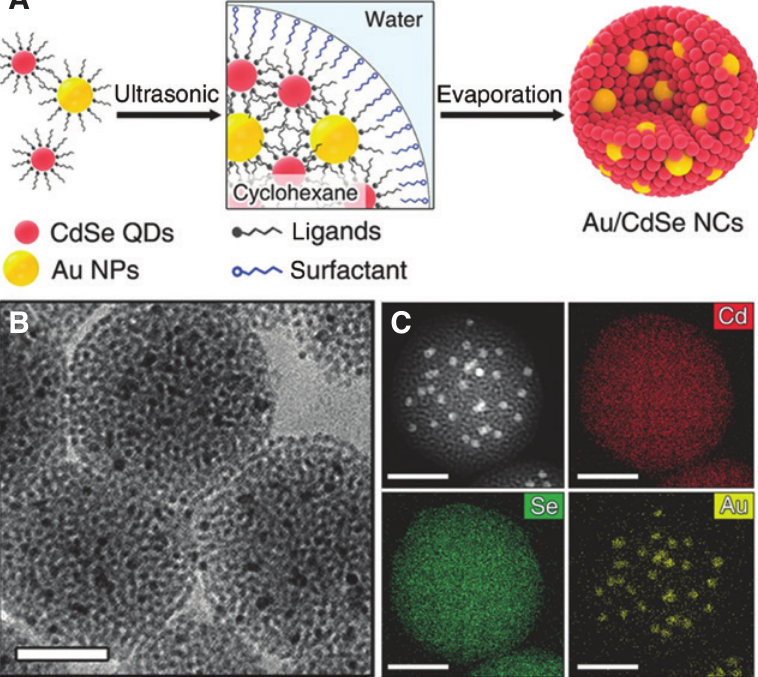
Figure 6: Preparation of nanoassemblies of AuNPs and CdSe QDs through the formation of emulsions. (A) Illustration of the process. Hydrophobic nanoparticles in cyclohexane are mixed with water and sonicated to form emulsions. (B) TEM image of emulsions containing AuNPs and CdSe QDs. (C) High-angle annular dark-field STEM image and corresponding EDS images for Cd, Se, and Au. Adapted with permission from Ref. [81]. Copyright 2017 John Wiley and Sons.